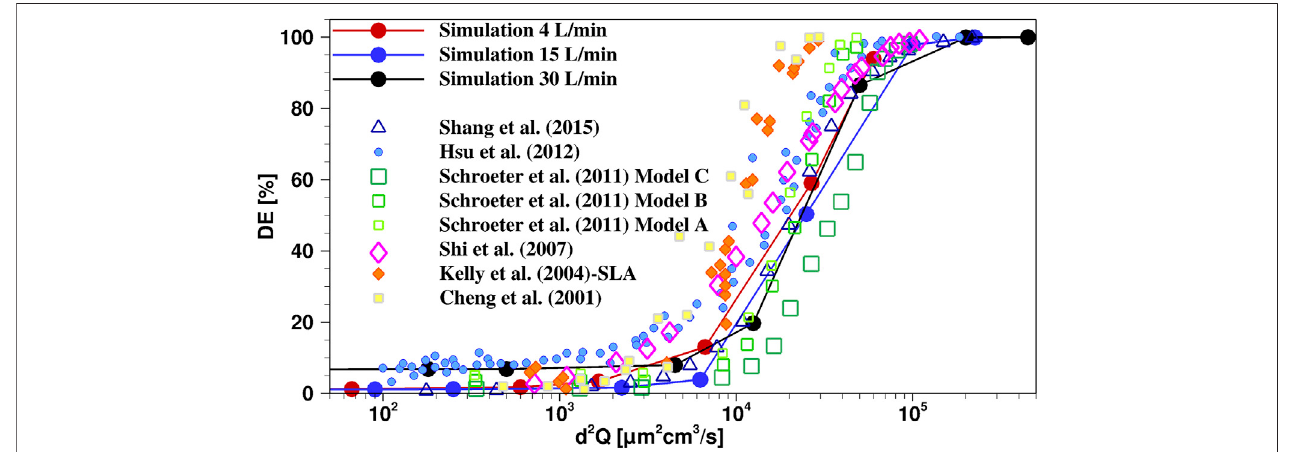
FIGURE2| Comparisonofpresent “ simulation ” resultswithexperimental(Chengetal.,2001;Kellyetal.,2004;Schroeteretal.,2011;HsuandChuang,2012)and numerical (Shi et al., 2007; Shang et al., 2015) studies in literature from different realistic nasal geometries and similar boundary and initial conditions. The 1 µm case is represented by the lowest d 2 Q value for each of the fl ow rate curves.